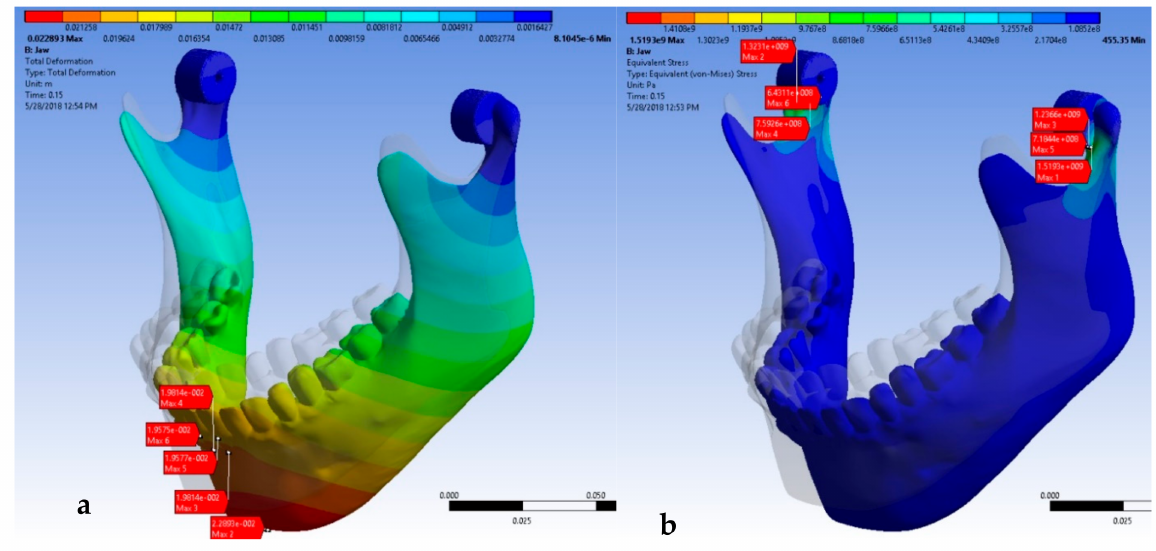
Figure 8. Deformation ( a ) and stress distribution ( b ) on the surface of the mandible in case of impact on the anterior face of the chin region (fractured teeth) in the mandibular complete edentation. The condylar process and the ramus of the mandible retained all the